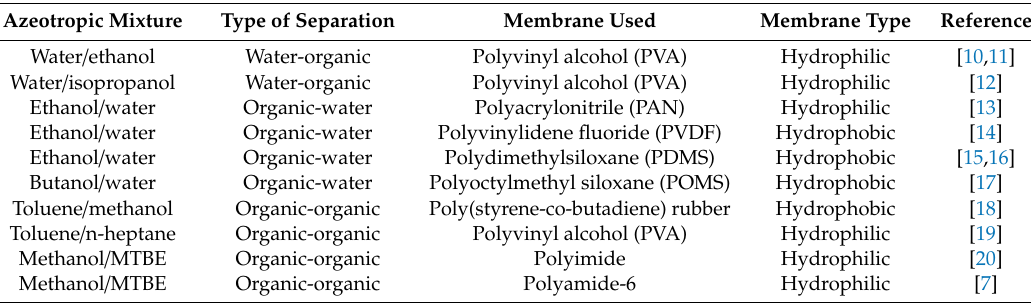
Table 1. Azeotropic separations using synthetic PV